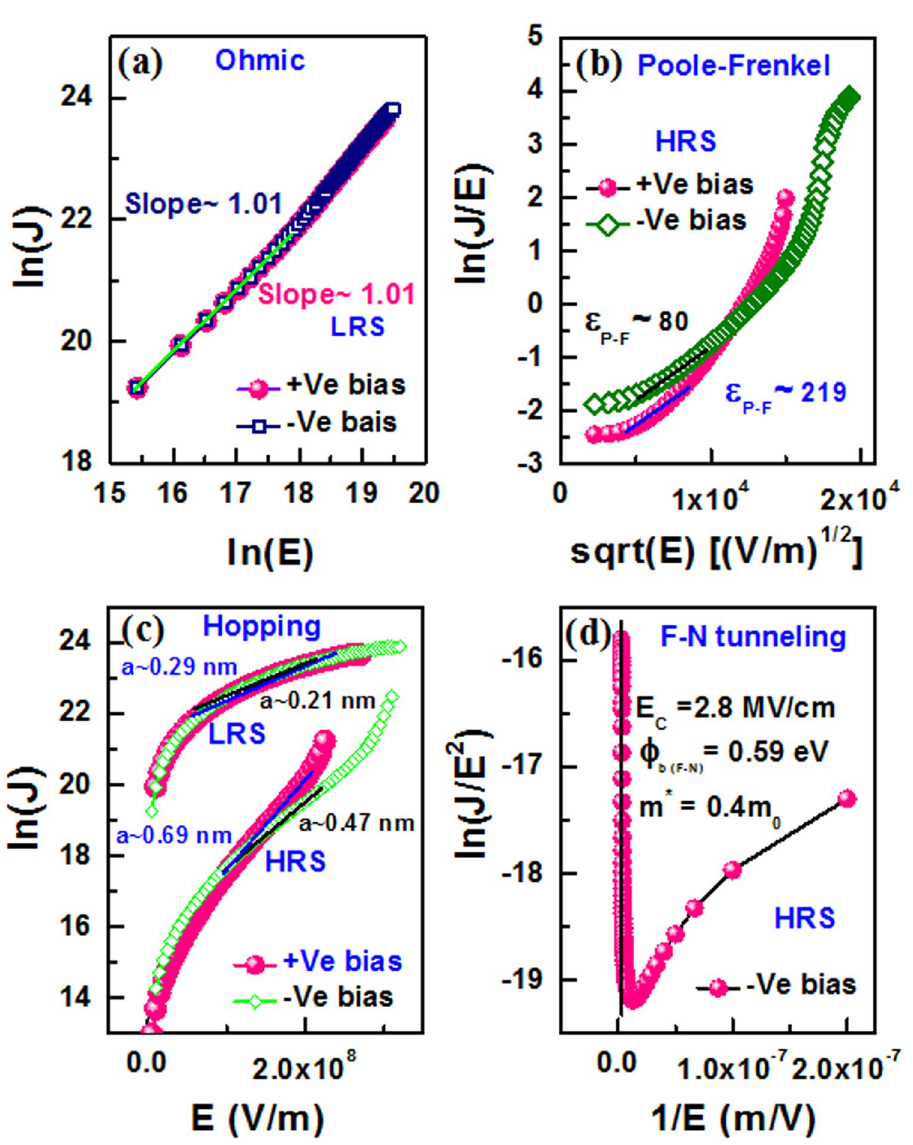
Figure 5. Current transport characteristics of S1 device with a size of 0.4 × 0.4 µ m 2 . ( a ) Ohmic conduction, ( b ) Poole-Frenkel (P-F), ( c ) Hopping conduction, and ( d ) Fowler-Nordheim (F-N)